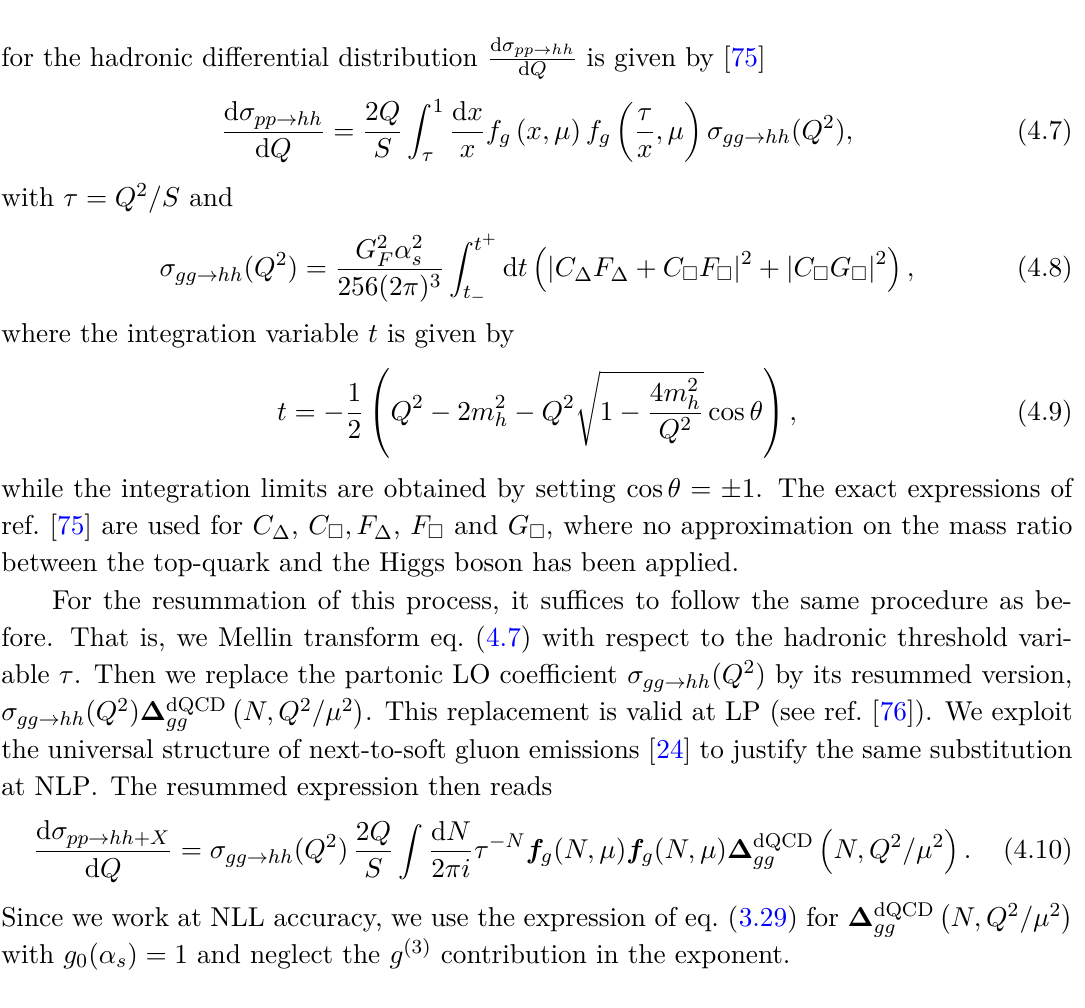
Figure 12. Ratio plot for the DY invariant mass distribution, normalized to the LO one (left) or NNLO one (right). The colour coding is the same as in figure 10. The scale variation is obtained by setting either to µ = Q/ 2 or µ = 2 Q